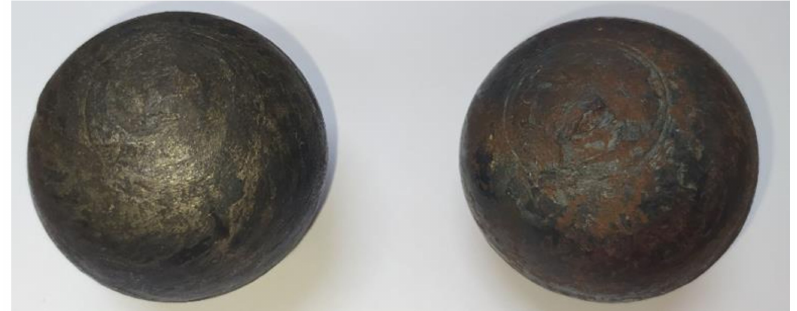
Figure 19. Steel balls Ø57 mm obtained by